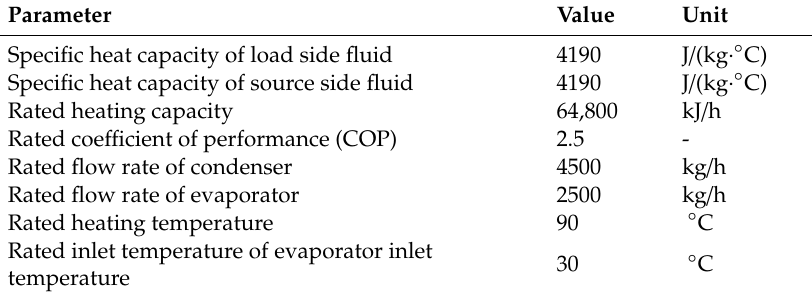
Table 5. Description of the high temperature water source heat pump (HHP).